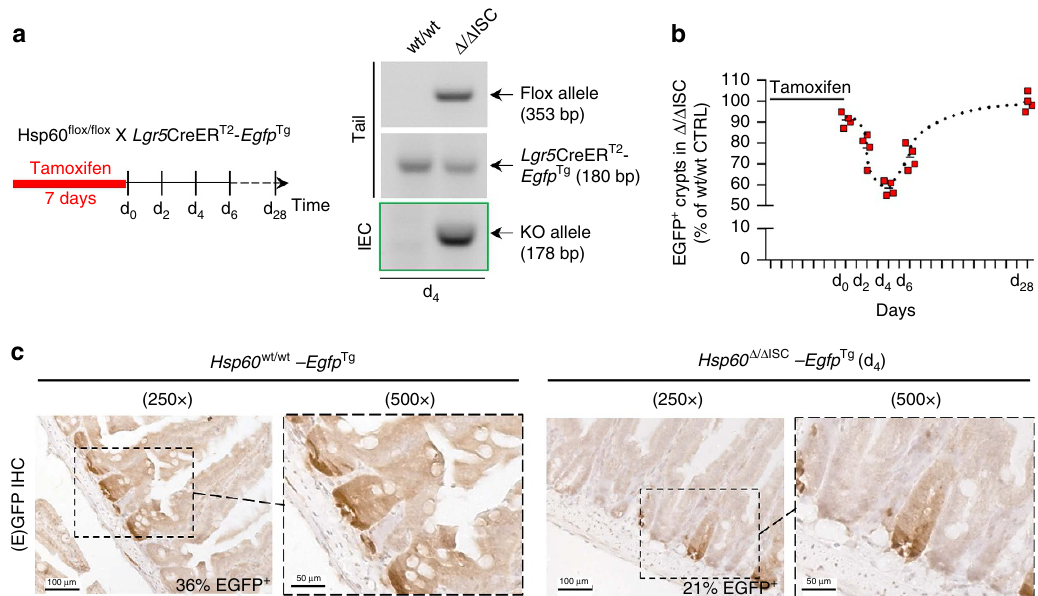
Figure 6 | HSP60 deficiency in Lgr5-positive cells induces intestinal stem cell loss. ( a ) Schedule for oral tamoxifen administration to induce HSP60 deficiency in intestinal stem cells (ISC, left) in Hsp60 flox /flox , Lgr5 CreER T2 - Egfp Tg mice. Agarose gel validating the presence of the knockout allele in IEC isolates (middle). ( b ) Quantification of EGFP-positive, Lgr5 expressing ISC containing crypts at different time points after ISC-specific Hsp60 deletion ( N ¼ 4 per genotype and time point) (right). ( c ) Representative IHC stainings for EGFP at d 4 are shown and the corresponding percentages of EGFP-positive crypts are indicated (lower